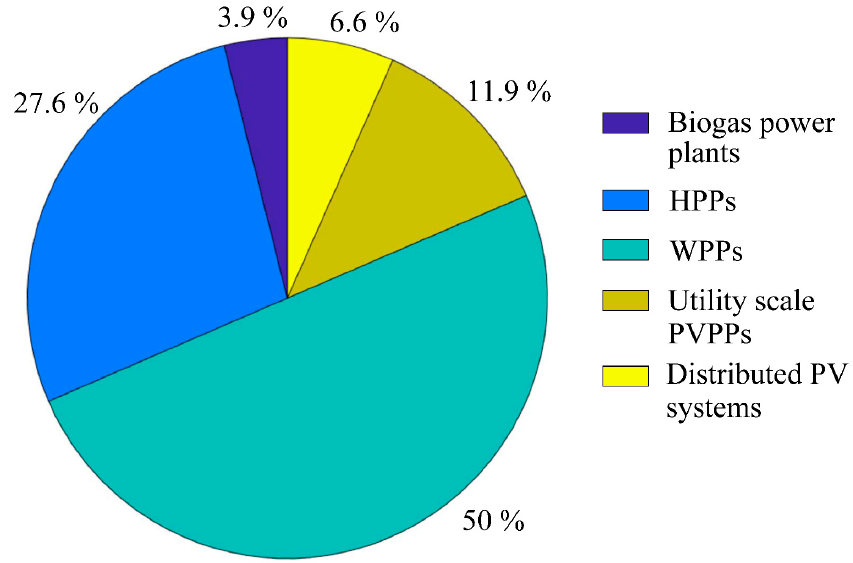
Figure 7. Electric energy generation structure in the completely decarbonized Serbian power system. Table 3. Characteristics of the consumption covering for the optimized structure and spatial alloca- tion of RES (for the analyzed three-year referent time period). The directly supplied energy is marked red as it is the main result.